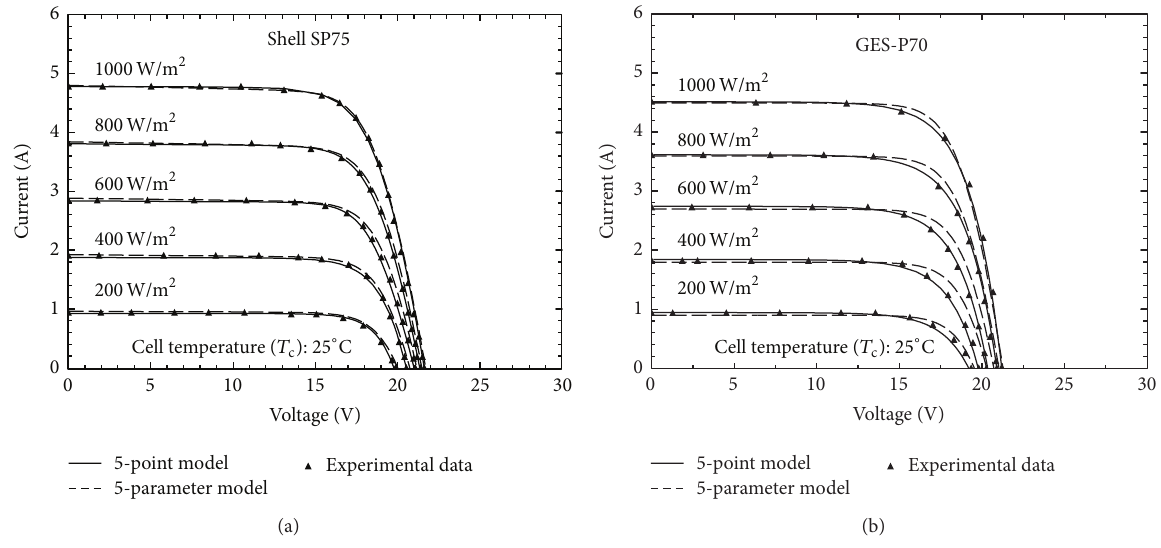
Figure 2: Calculated I-V curves and experimental data of Shell SP75 (a) and GES-P70 (b) at different irradiance, 25 ∘ C.